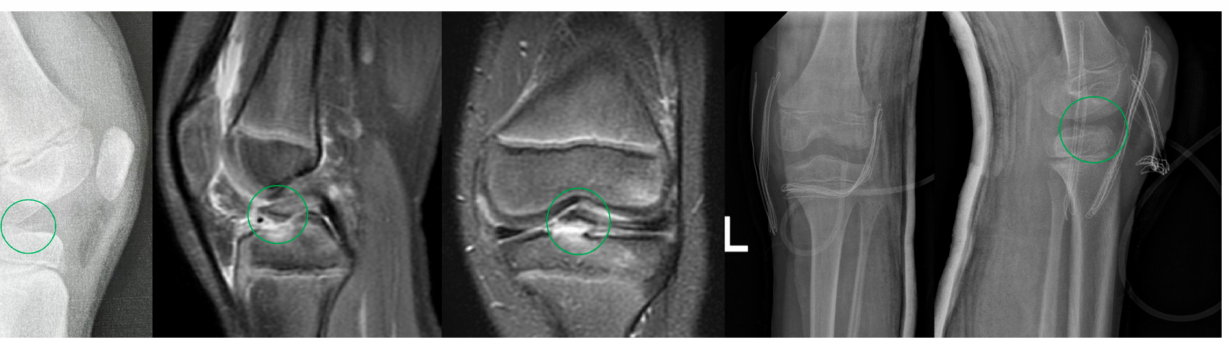
Figure 3. 9-year-old boy with a left (L) tibial eminence fracture. Chronological: lateral X-ray after injury, sagittal and coronal MRI scans before surgery, AP, and lateral X-rays one day after ARIF procedure (fixation with 2 SmartNails). Tibial eminences were